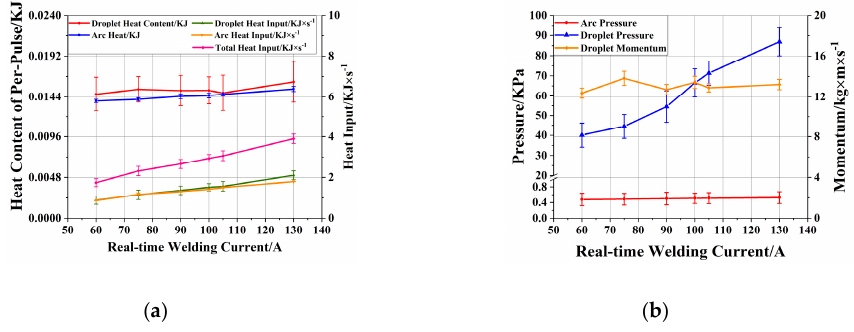
Figure 10. Heat input ( a ), pressure and momentum ( b ) of arc and droplet during single current-pulse with different welding currents.